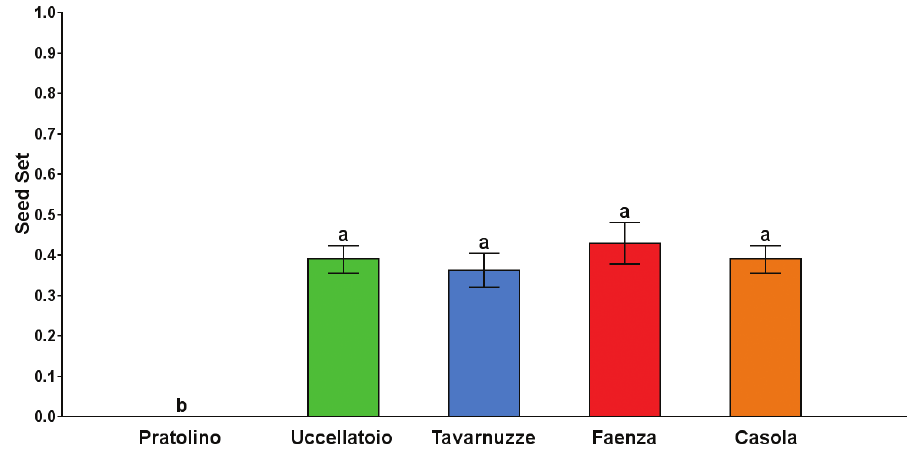
Figure 4. Box-chart of seed set in the studied Bellevalia webbiana populations (confidence interval, 95%). Different letters indicate statistically significant differences at 0.01